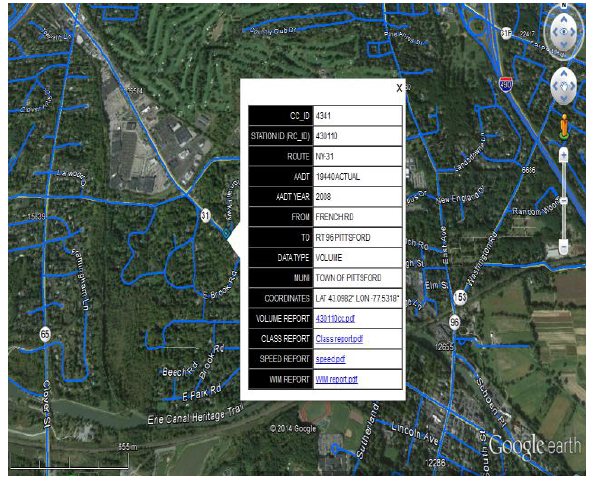
Figure 4. The location and specification of the traffic